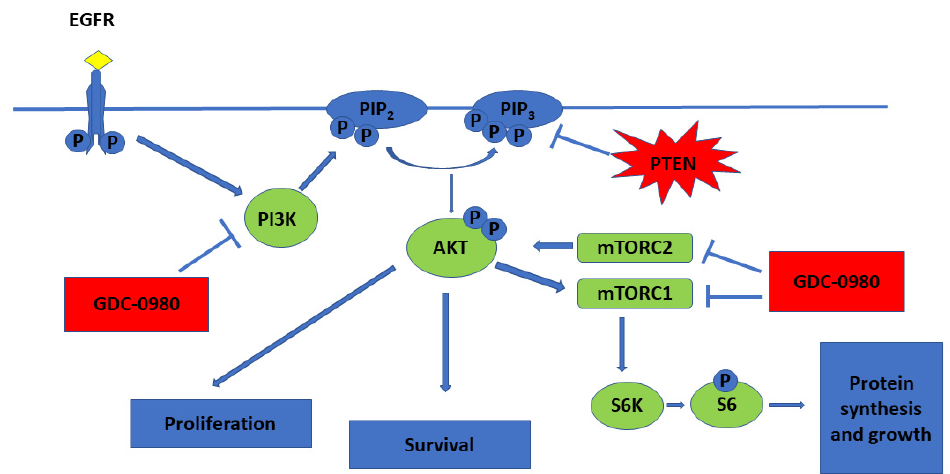
Figure 1. PI3K/mTOR pathway and mechanistic effects of GDC-0980 treatment in tumour cell lines